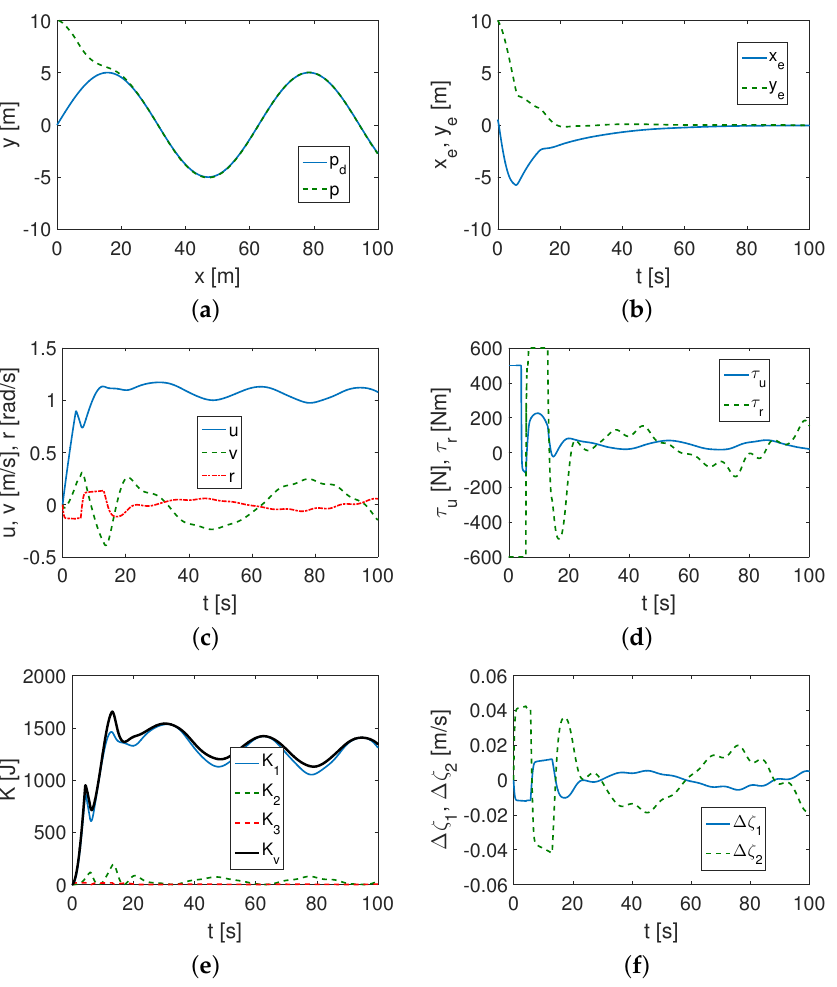
Figure 3. Results for the SIRENE, QV controller and sine trajectory: ( a ) desired and realized trajectory; ( b ) position errors; ( c ) velocity errors; ( d ) applied force and torque; ( e ) kinetic energy time history; ( f ) quasi-velocity errors ∆ ζ 1 , ∆ ζ 2